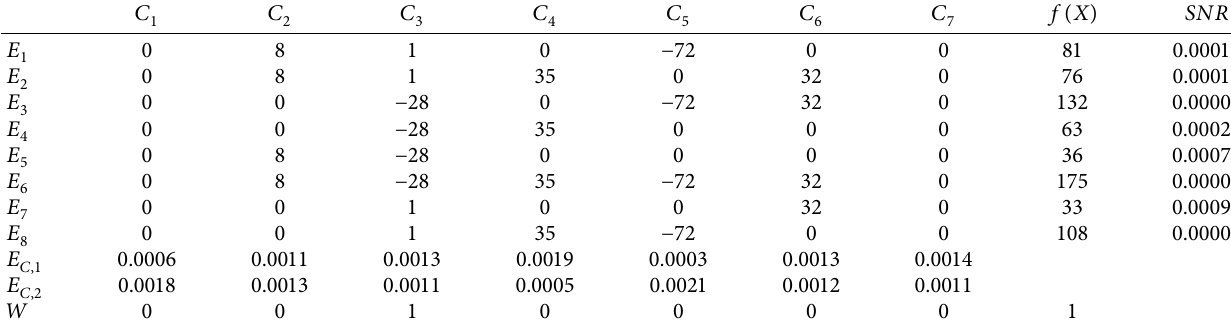
Table 2: Te process of Taguchi parameter design method acting on the individuals V and X .